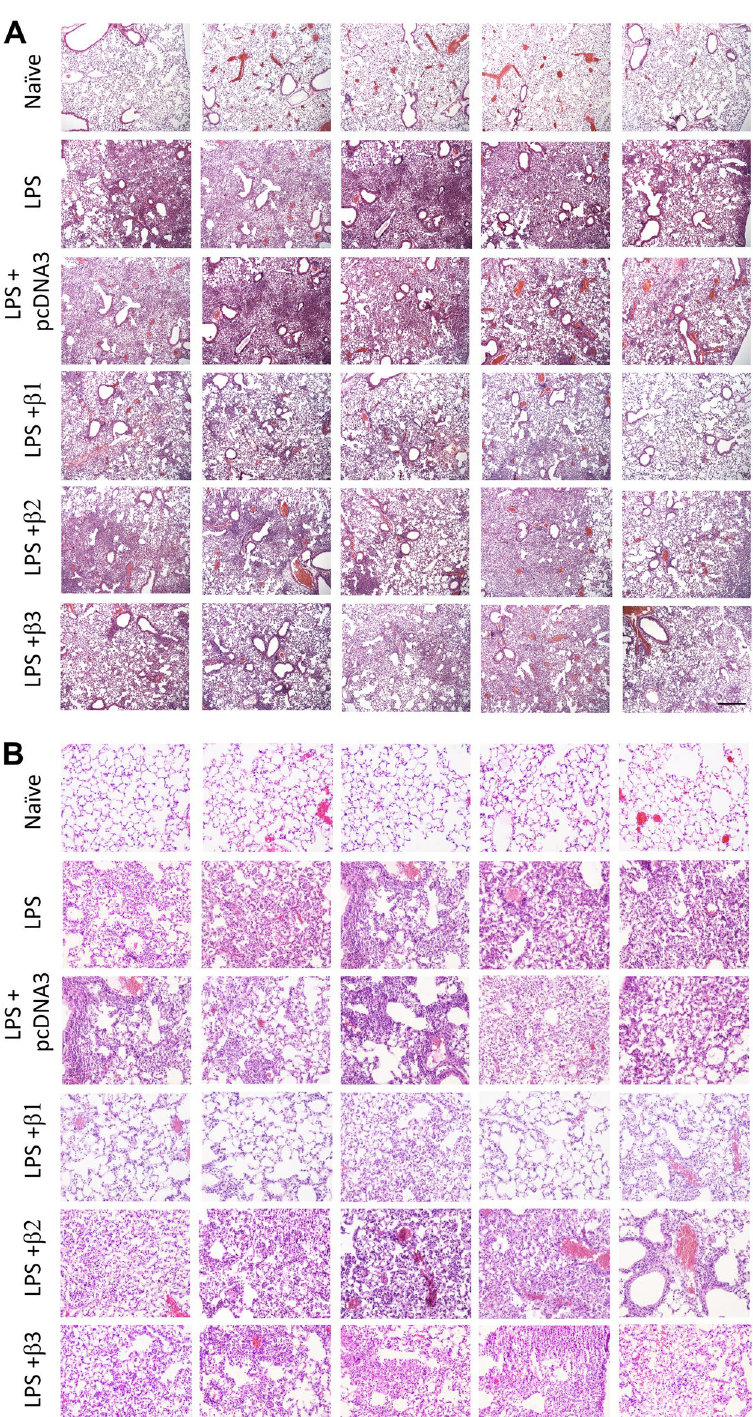
Figure 3. Overexpression of the β2 or β3 subunits of the Na + ,K + -ATPase fails to attenuate LPS-induced lung injury. Lung injury was established in mice (n = 6–8) by aspiration of LPS (5 mg/kg) and 1 day later plasmids (100 μg each) expressing either no insert (pcDNA3), or the β1, β2, or β3 subunits of the Na + ,K + -ATPase (β1, β2, or β3) were electroporated into lungs as in Fig. 2. Naïve mice (n = 5) received no LPS or DNA. Two days after electroporation (3 days after LPS administration), lungs were inflated to 20 cm H 2 O with 10% buffered formalin and processed for paraffin-embedding, sectioning, and hematoxylin and eosin staining. Sections from 5 representative animals are shown at ×50 ( A ) and ×400 ( B ) magnification. All experiments were carried out three times and a representative experiment is shown. Scale bar is 300 μm ( A ) and 100 μm ( B